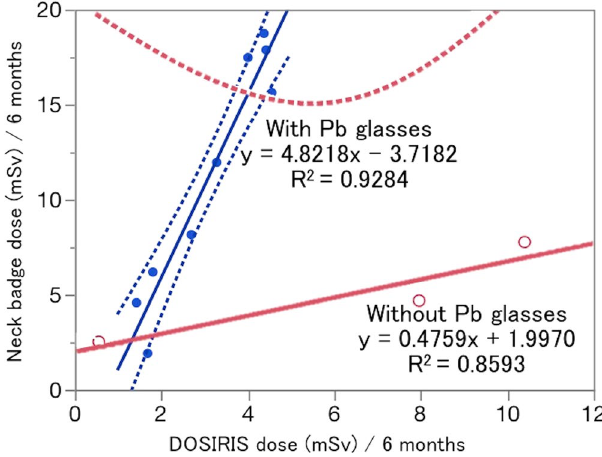
Figure 2. Relationship between the eye dose (DOSIRIS) measurements and neck badge dose measurements for 6 months in 12 IC physicians: nine physicians used Pb glasses and three did not. Dashed line (---): 95% confidence interval.